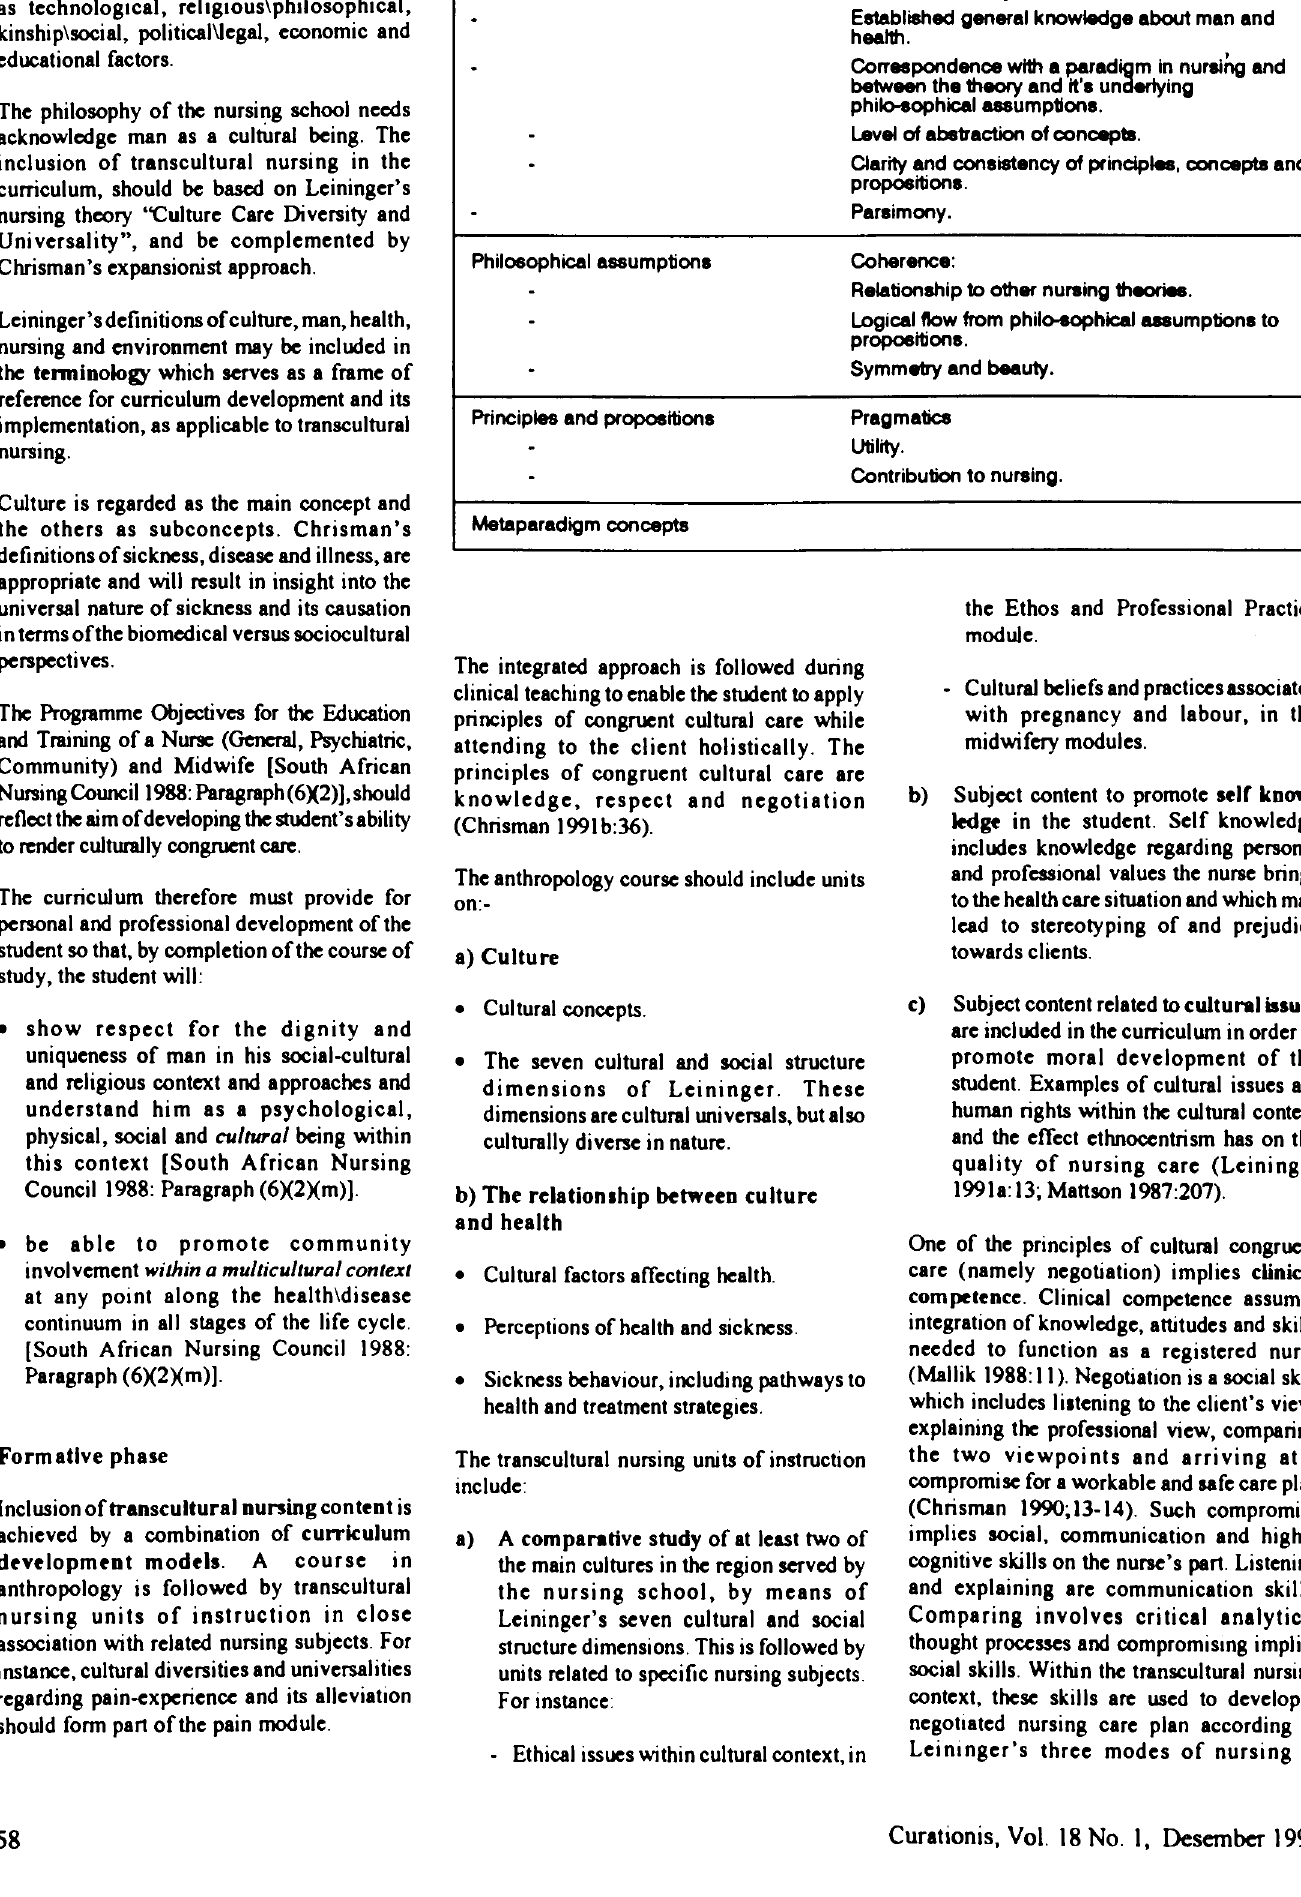
Table 2 Analysis and evaluation of Leininger’s nursing theory STRUCTURE